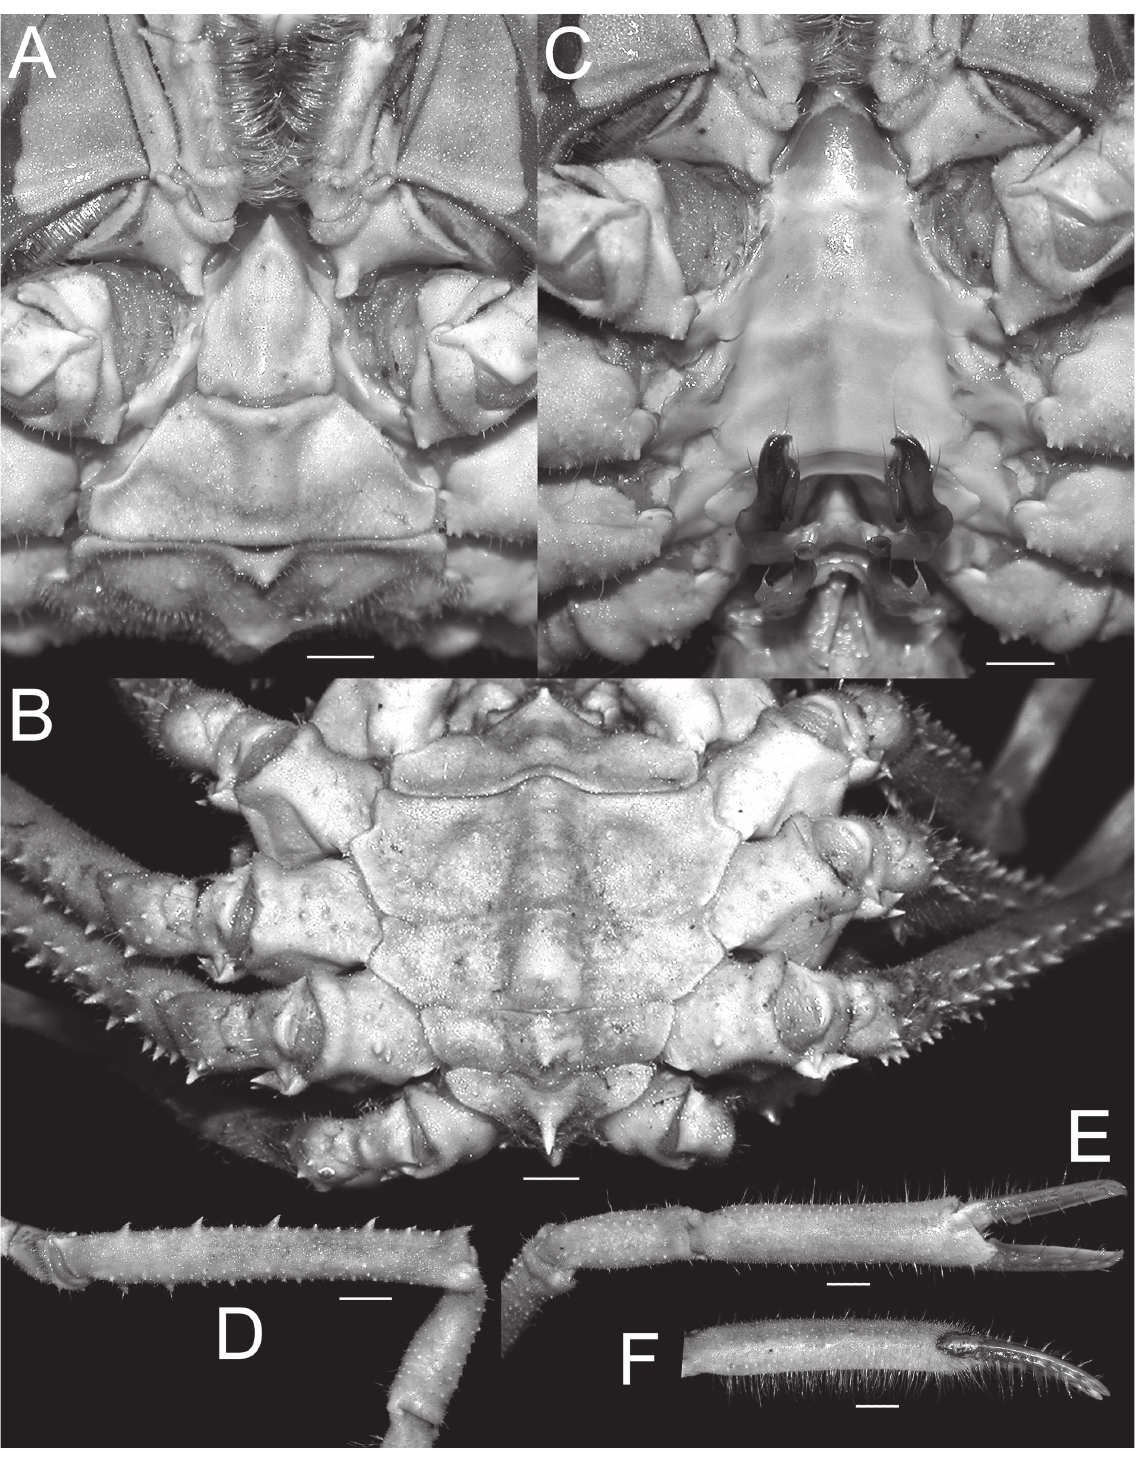
Fig. 9. Moloha tumida sp. nov. Holotype, ♂ (cl 55.7 mm, cw 50.6 mm) (DABFUK), Kerala, India. A . Telson and pleonal somites 5 and 6. B . Pleonal somites 2–6. C . Sternopleonal cavity. D . Merus and carpus of right cheliped. E . Outer view of right chela. F . Ventro-marginal view of right chela. Scale bars = 5